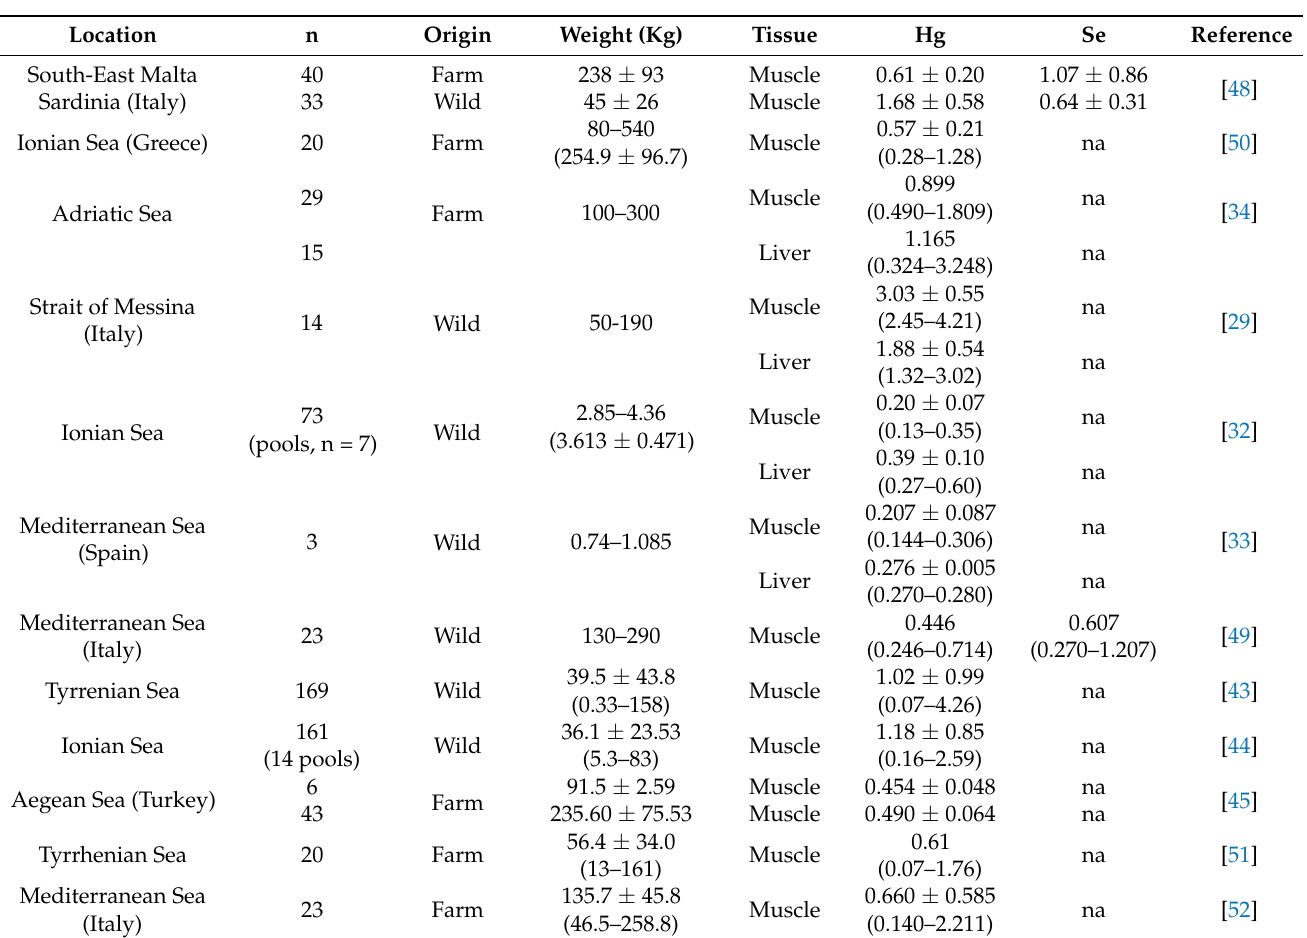
Table 5. Total mercury and Se concentrations in ABFT from Mediterranean Sea. Data: mean ± standard deviation, µ g g − 1 ,